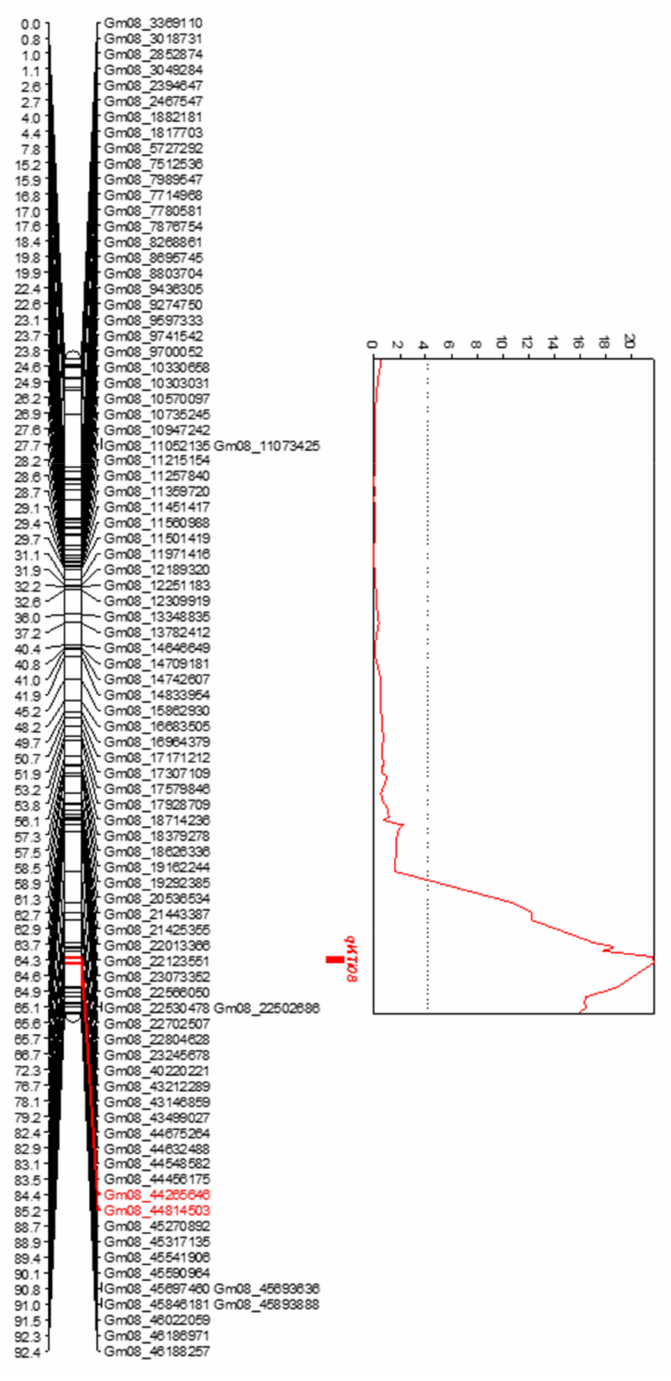
Figure 3. Quantitative trait loci (QTL) mapping of qKTI08 in chromosome 8 (LG A2) in the biparental mapping population derived from Glenn x PI